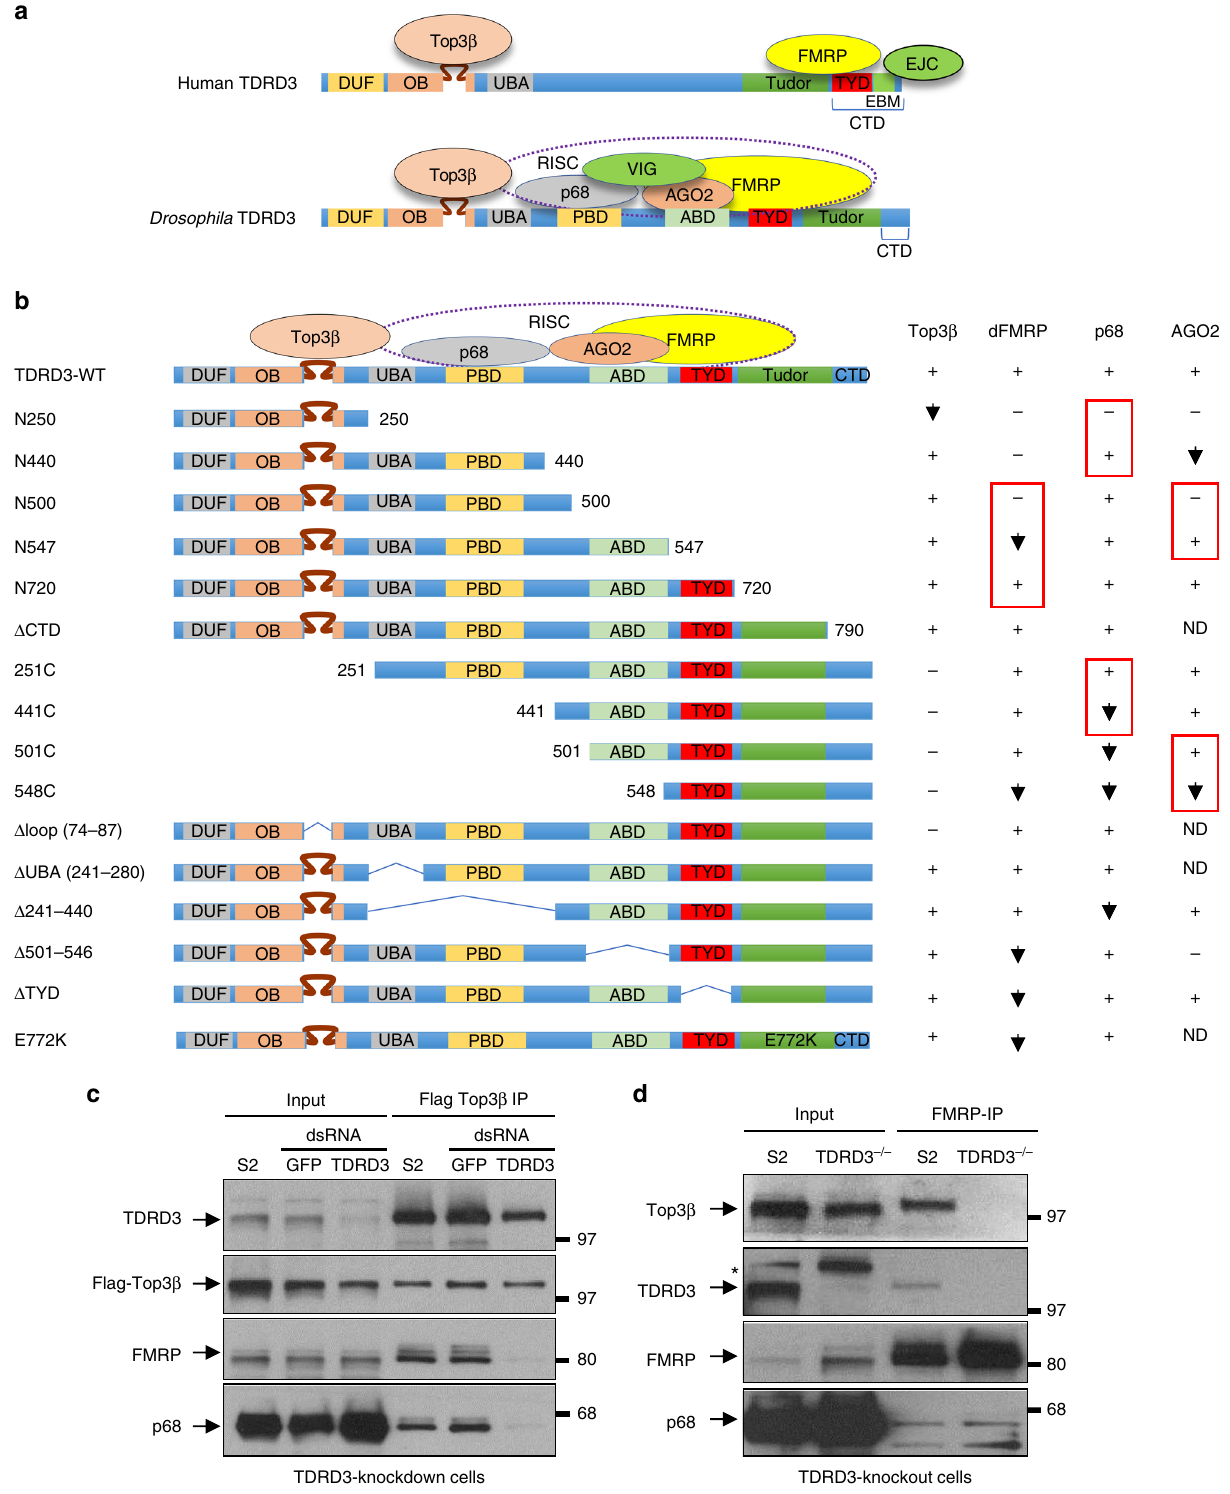
Fig. 2 TDRD3 acts as a scaffold linking Drosophila Top3 β to RISC. a A cartoon shows similarity and differences between human and Drosophila Top3 β - TDRD3 complexes (see Results for details). b Summary of domain-mapping experiment to show different mutants of TDRD3 (left), and their interactions with Top3 β and components of RISC (right). The experiment was based on co-IP between different Flag-TDRD3 constructs and their interacting partners from transfected S2 cells. The detailed IP-Western data are in Supplemental fi gure (Supplementary Fig. 2A). The presence ( + ), absence ( − ), or reduction (down arrow), of interactions are indicated. c IP-Western shows that FLAG-Top3 β co-IPs with reduced amount of FMRP and p68 in S2 cells depleted with TDRD3 by RNAi. A control experiment was included using RNAi that targets GFP. d IP-Western shows that FMRP co-IPs with reduced amount of Top3 β , but normal amount of p68, in S2 cells inactivated of TDRD3 by